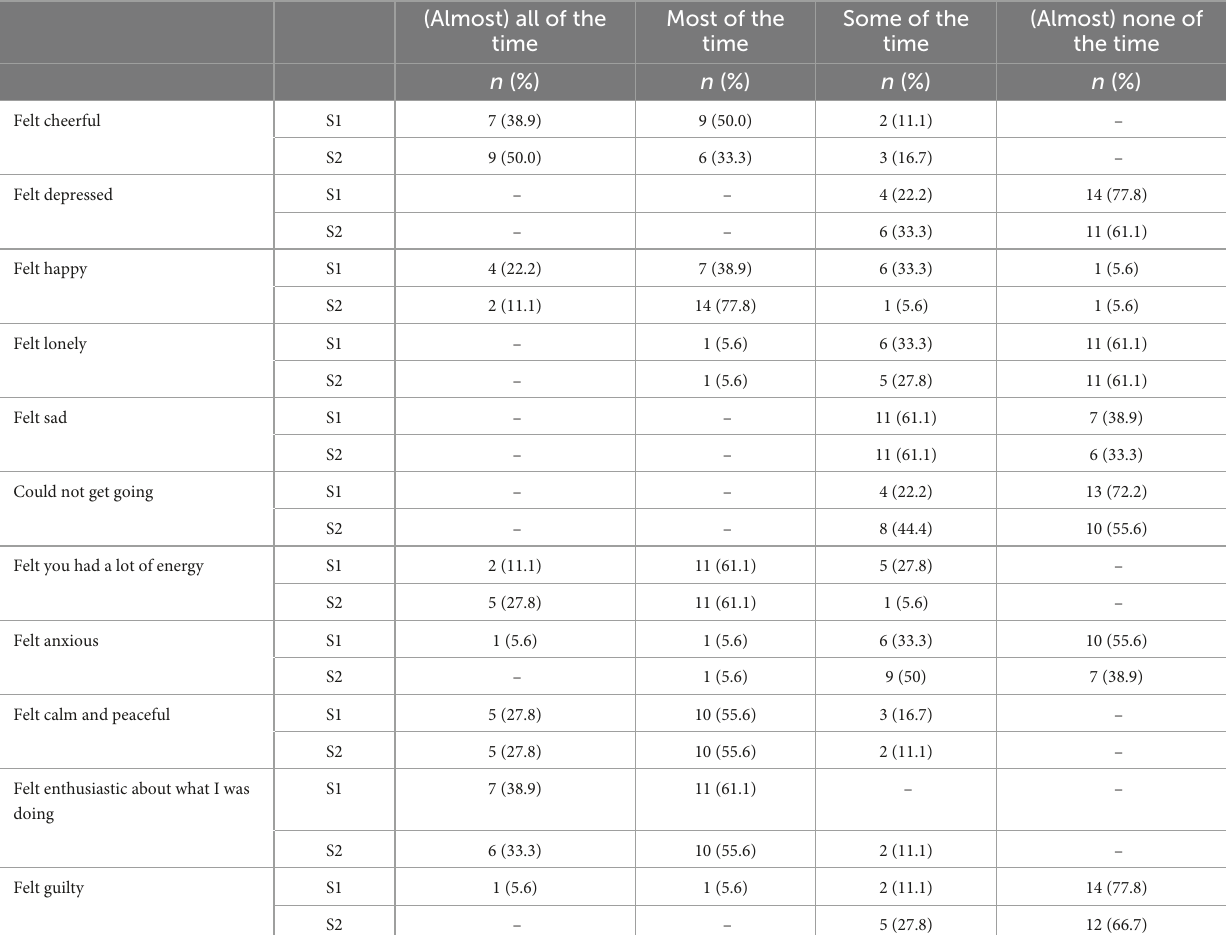
TABLE 5 Mood in Survey 1 and Survey